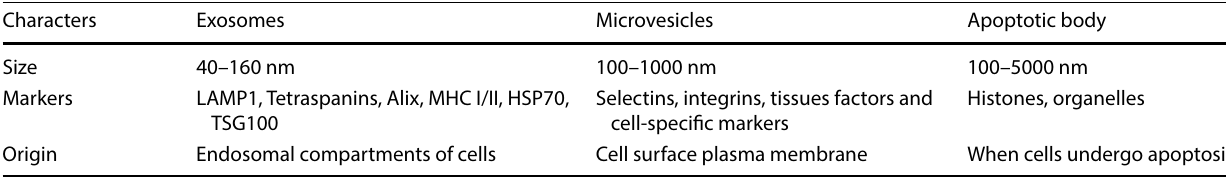
Table 1 Classification of extracellular